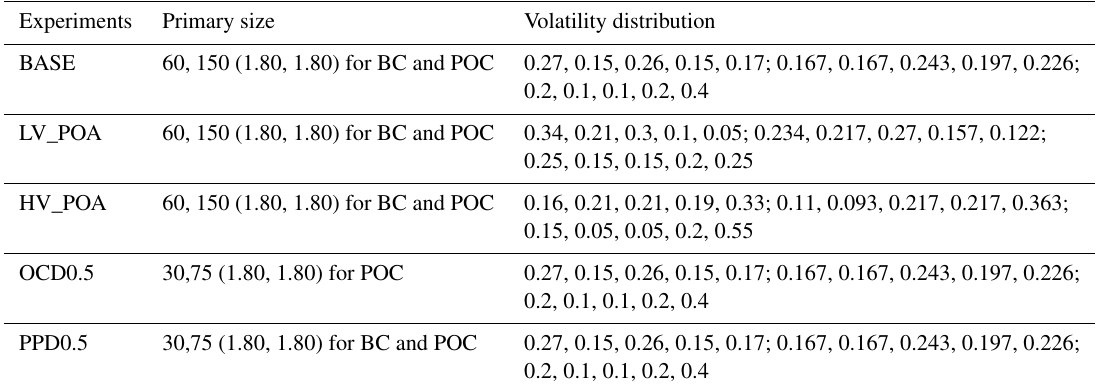
Table 2. Sensitivity experiments and their description. The “Primary size” column refers to the geometric mean diameter values (nm) assumed for primary carbonaceous aerosol emissions. The “Volatility distribution” column refers to the coefficients of POA distributed to the volatility bins for vehicles, other anthropogenic, and biomass burning, respectively. Coefficients for different sources are separated by semicolons and different bins (from the lowest to the highest) by